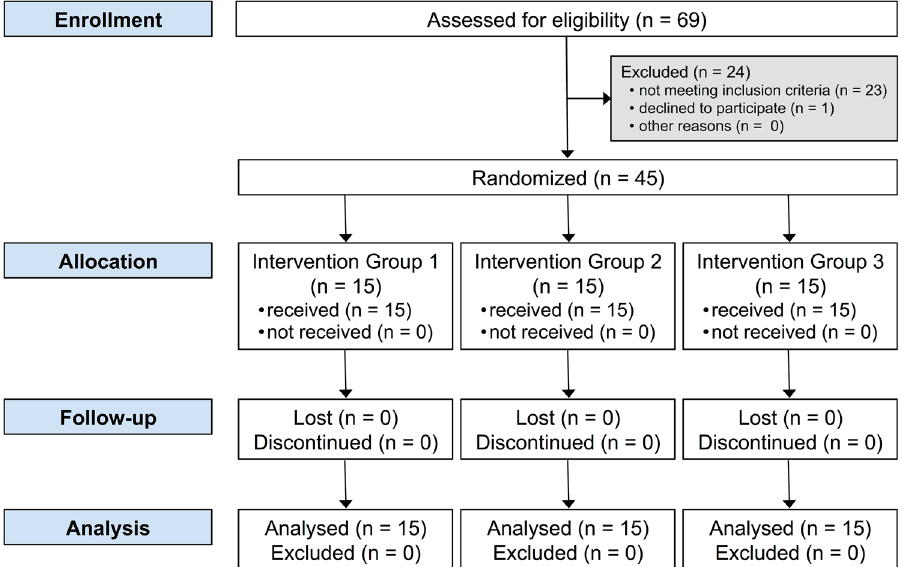
Figure 1. Graphic depiction of flow of participants through each stage of randomized trial. Group 1 = Teeth bleached with ozone then 38% hydrogen peroxide; Group 2 = Teeth bleached with 38% hydrogen peroxide then ozone; Group 3 (control) = Teeth bleached with 38% hydrogen peroxide